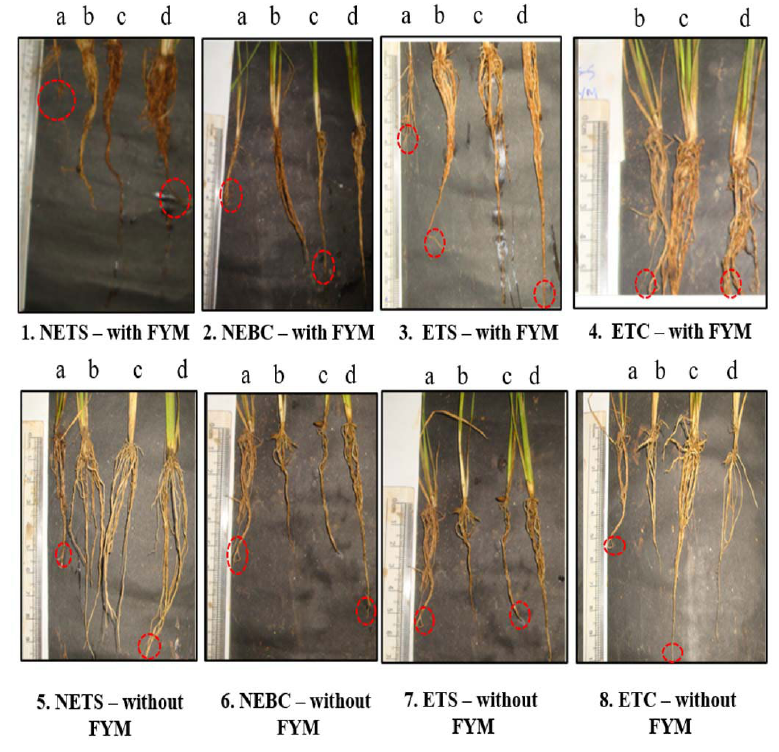
Fig. 1. Effect of different forms of Bioformulation on 30 th day of seed sowing in root length. a - control; b – Seed Treatment; c – Seed treatment + Soil application; d – Soil